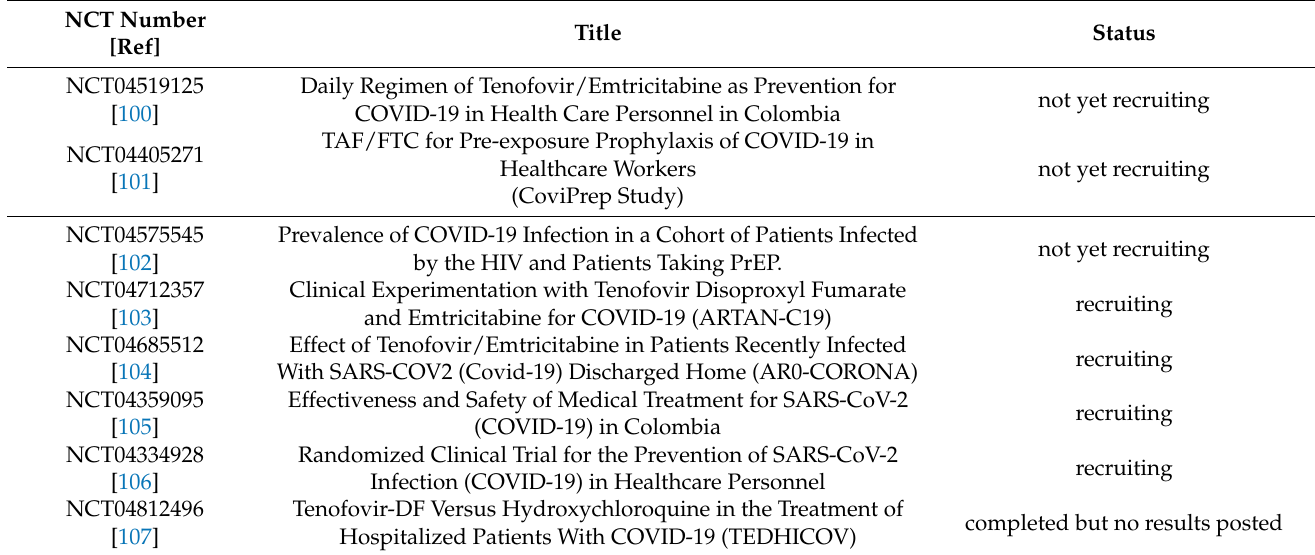
Table 1. Clinical trials currently investigating TDF/TAF efficacy in COVID-19 treatment or